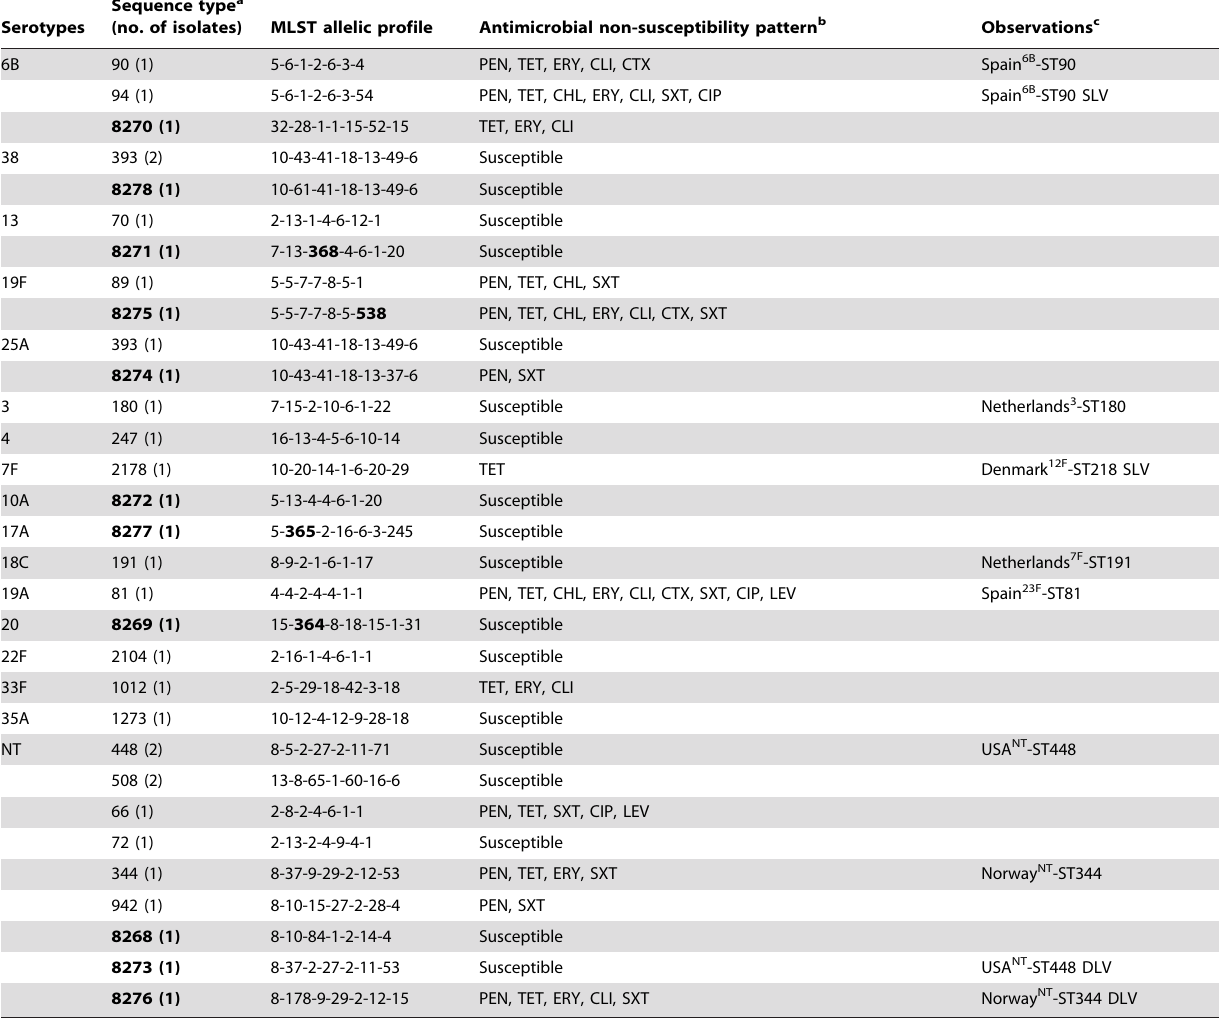
Table 3. Properties of S. pneumoniae clinical